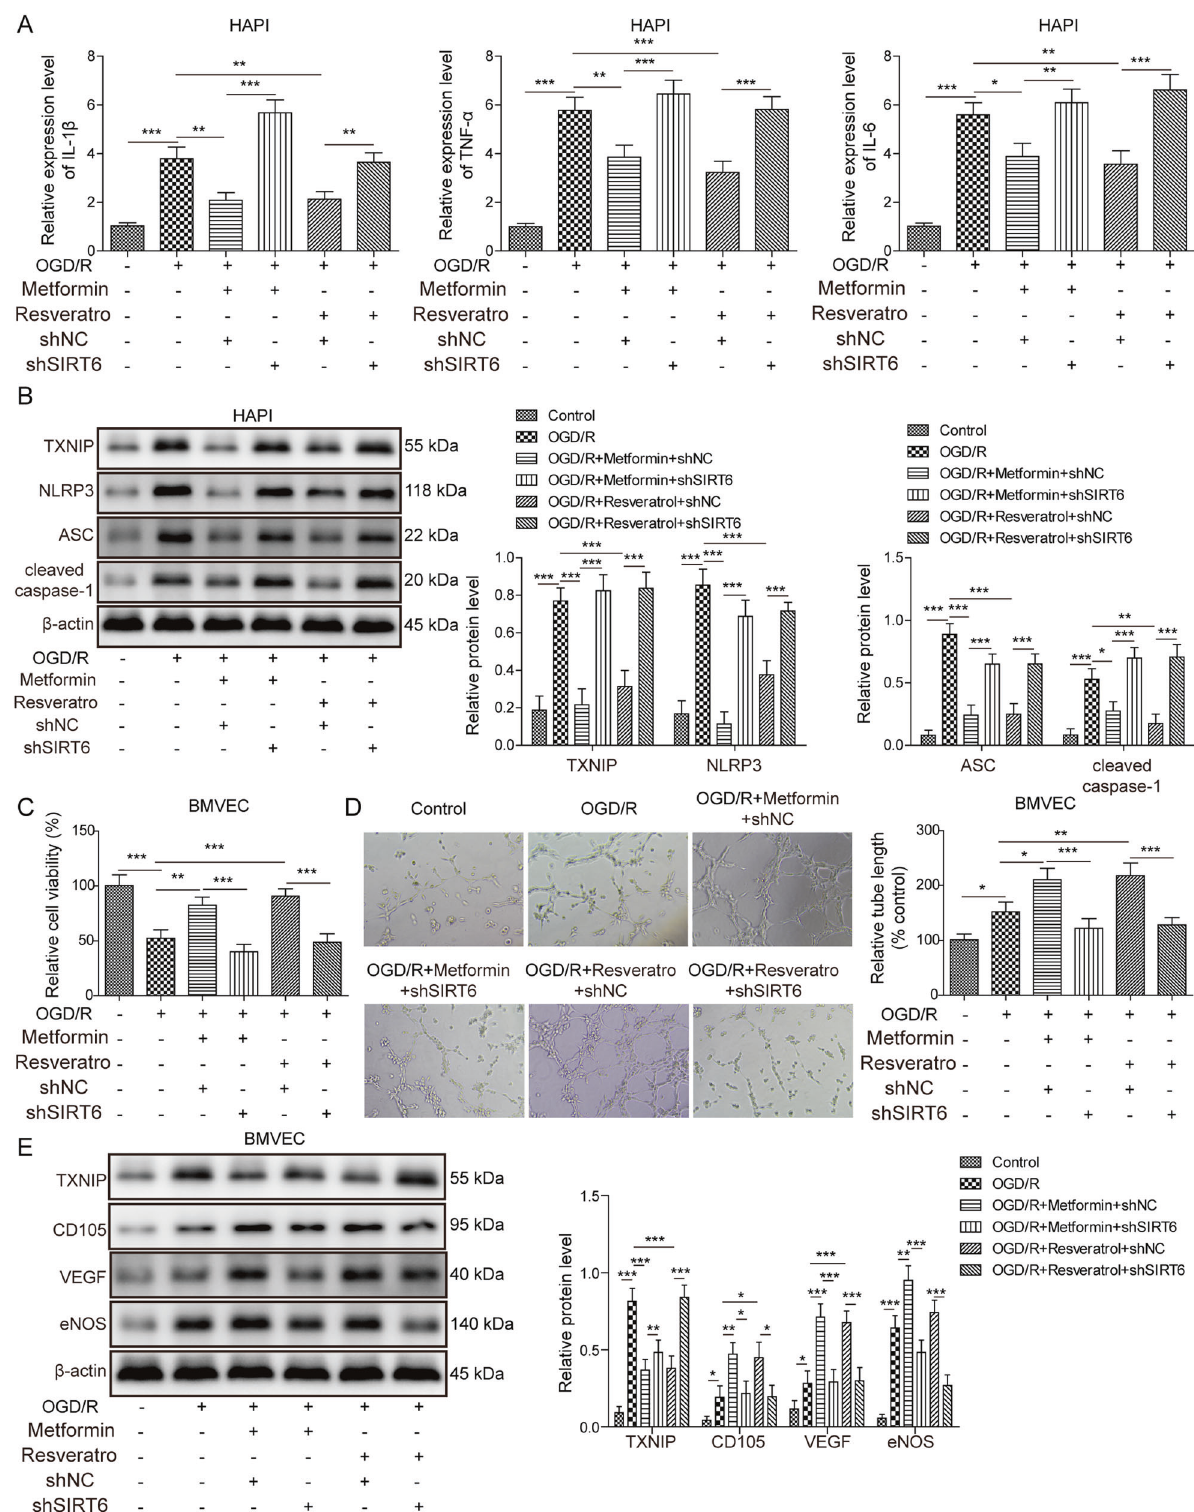
Fig. 6 ER mimetics modulates OGD/R-induced microglial activation and angiogenesis partially via SIRT6. shNC or shSIRT6 lentivirus- infected HAPI cells and BMVECs were pre-treated with vehicle control, metformin or resveratrol for 12 h, followed by OGD/R treatment. A The mRNA levels of cytokines in HAPI cells were determined by qRT-PCR. B The protein levels of target proteins in HAPI cells were determined by Western blotting. C The cell viability of BMVECs was monitored by MTT assays. D The angiogenesis of BMVECs was evaluated by tube formation assay. E The protein levels of target proteins in BMVECs were determined by Western blotting. β -actin acted as a loading control for Western blotting. * p < 0.05, ** p < 0.01, and *** p < 0.001.